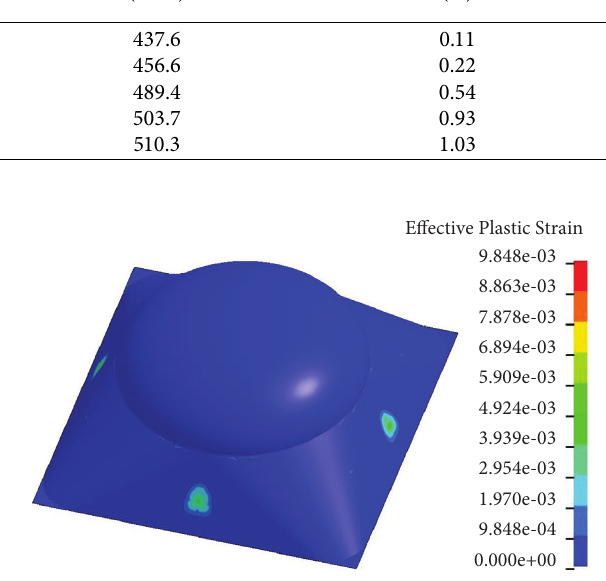
Figure 17: The maximum effective plastic strain contour of the EBD at 1 atm.